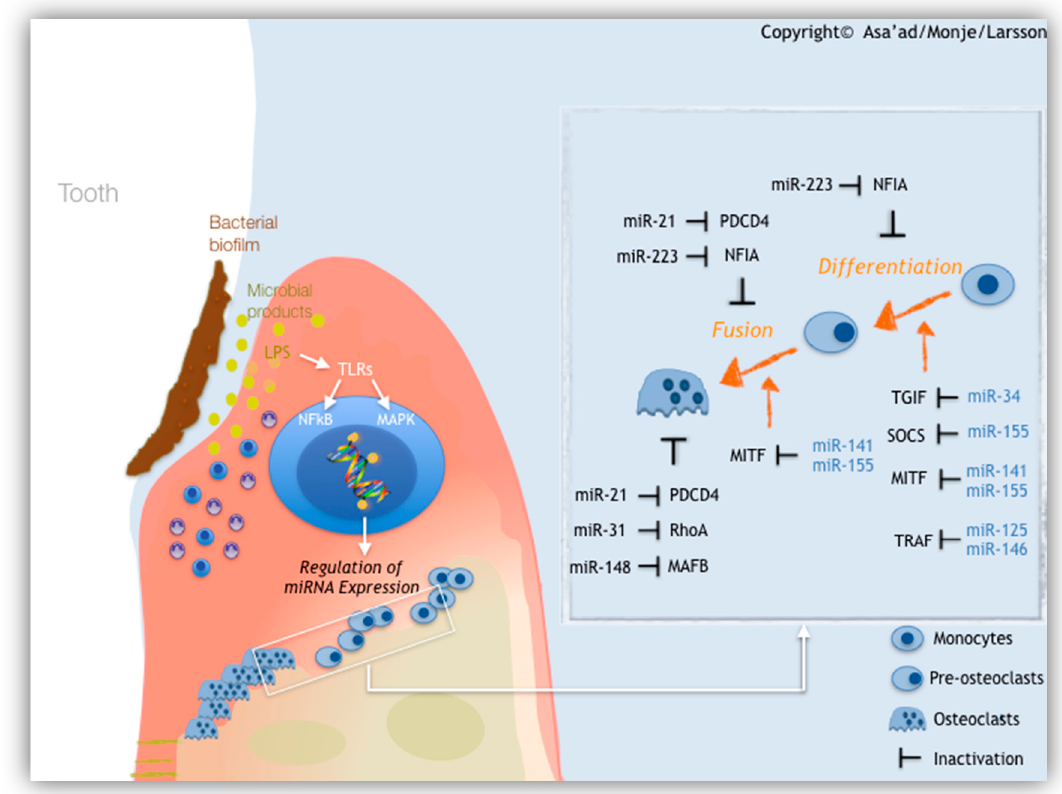
Figure 2. MicroRNAs expressed in periodontitis and their target in alveolar bone. The illustration briefly demonstrates the influence of bacterial biofilm on the expression of miRNAs. When tissues are exposed to bacterial lipopolysaccharide (LPS), expressed miRNAs can increase the sensitivity of toll-like receptors (TLRs) or can target NF- κ B signaling pathway or can mediate endotoxin tolerance through modulation of mitogen-activated protein kinase (MAPK) pathway. MiRNAs 21, 31, 148, and 223 are positive regulators of osteoclastogenesis and osteoclastic di ff erentiation. MiRNAs 34, 125, 141, 146, and 155 are negative regulators of osteoclastogenesis and osteoclastic di ff erentiation. From Asa’ad et al., 2019, Eur J Oral Sci. Reproduced with permission from John Wiley and Sons. Copyright 2019.